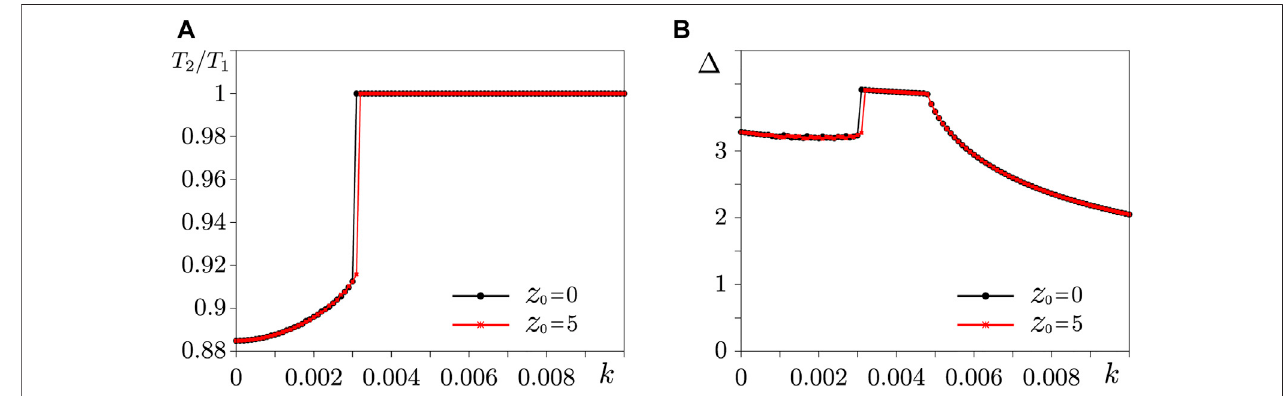
FIGURE6| Synchronizationcharacteristicsintwonon-identicalrings( σ 1 =4.5, σ 2 =5.5)coupledvianon-idealmemristorswith δ =0.1:dependenciesoftheratioof average oscillation periods T 2 / T 1 (A) and synchronization errors Δ (B) on the coupling coef fi cient k calculated at z 0 = 0, z 0 = 5.0.